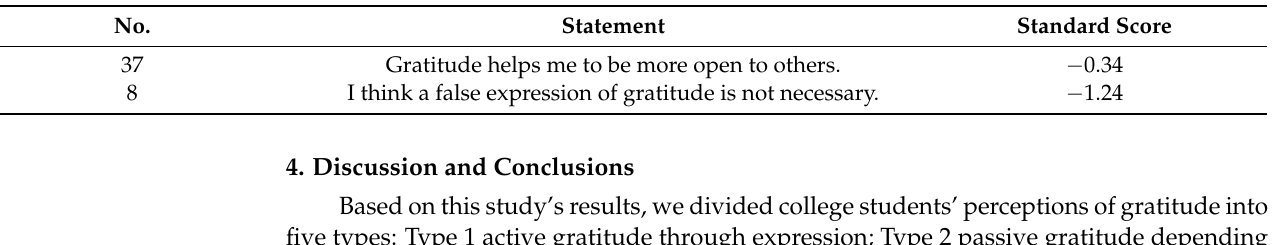
Table 12. Consensus items of each